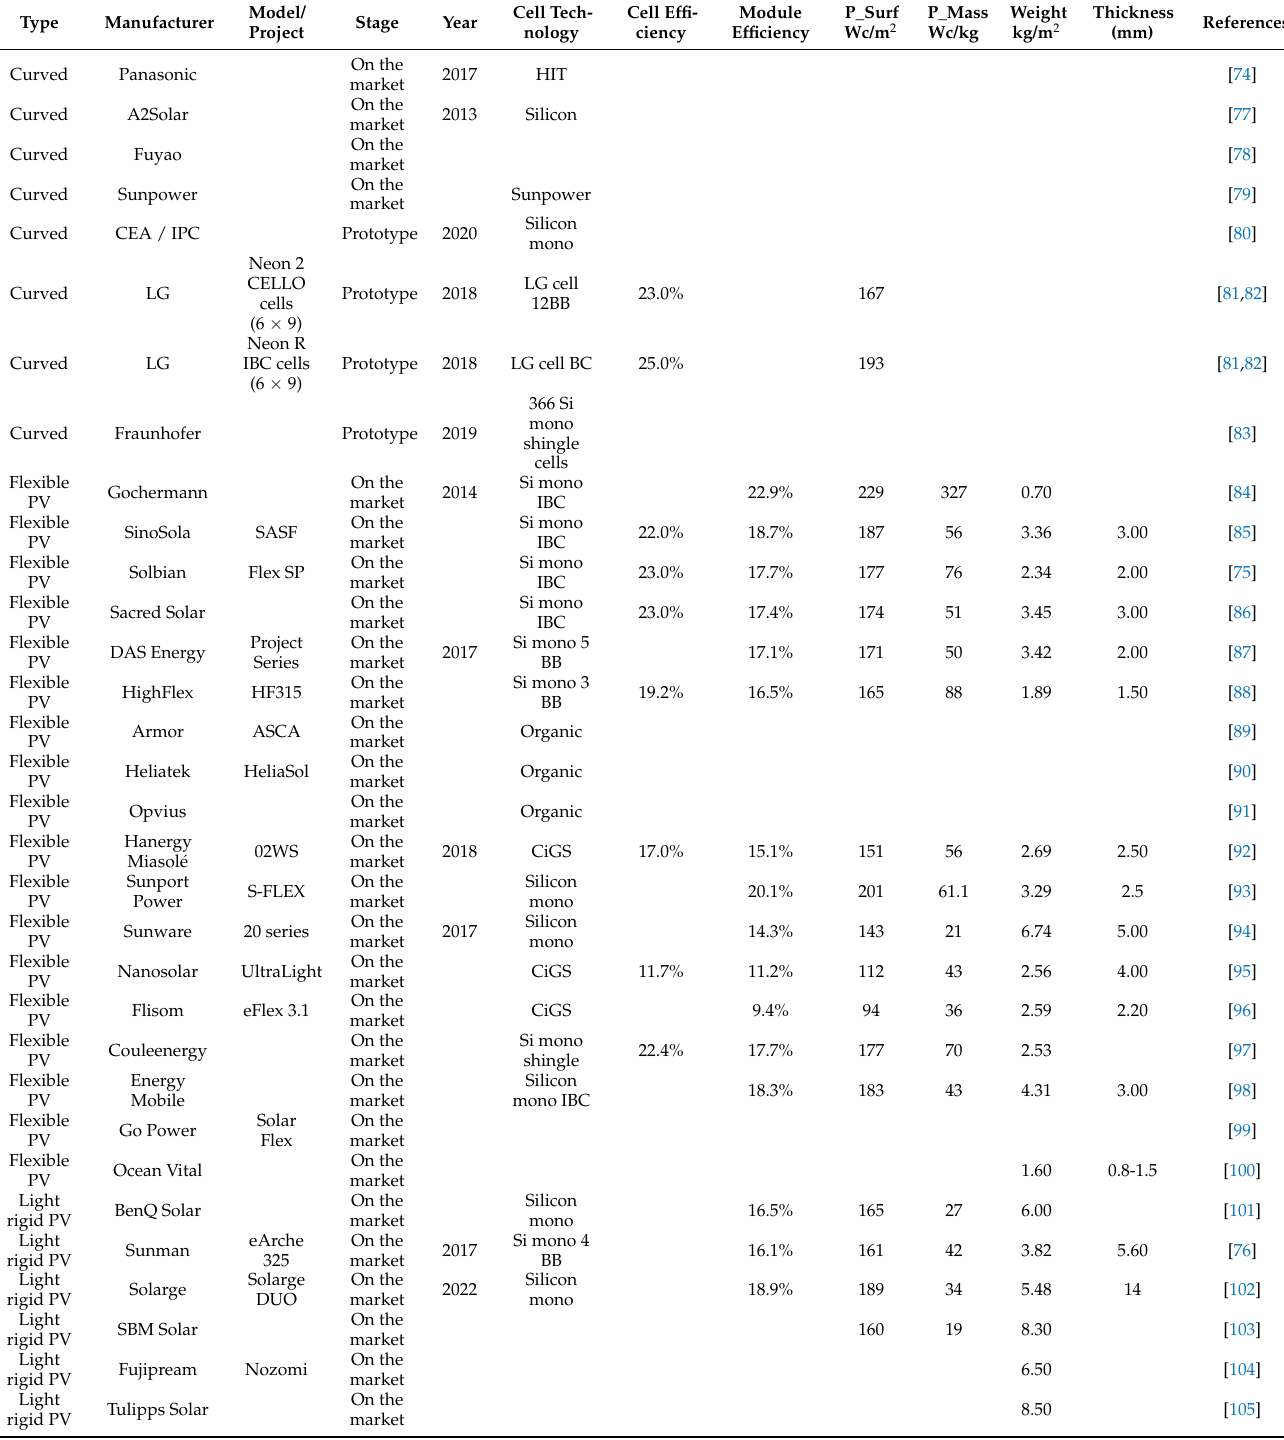
Table 2. Non-comprehensive chart of light rigid and/or flexible PV technologies and their